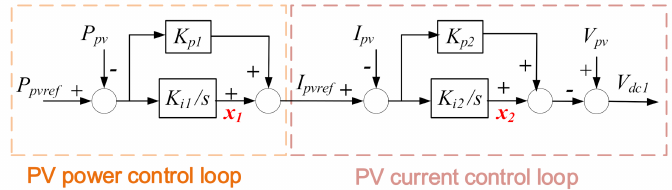
Figure 4. Control structure of DC/DC